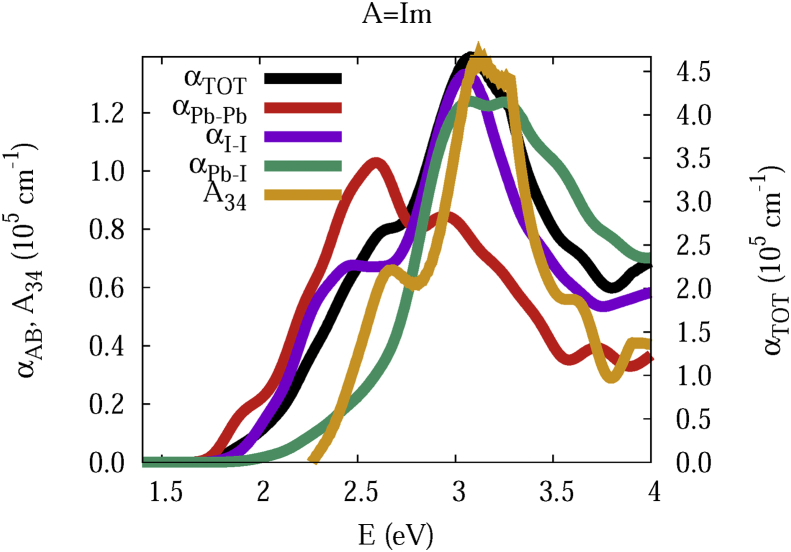
Same legend as that in Fig. 1, but for A = Im.